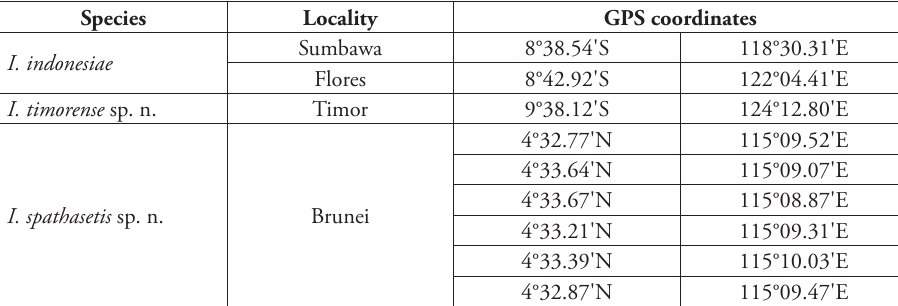
Table 2. GPS coordinates of locations of examined